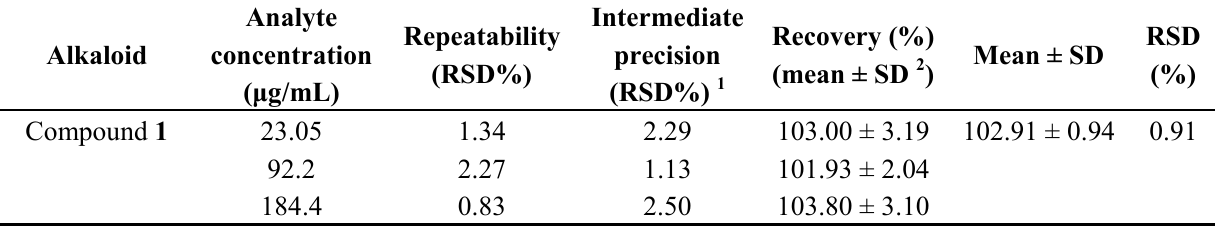
Table 1. Repeatability, intermediate precision, and accuracy data of the method for the standard determination by HPLC.